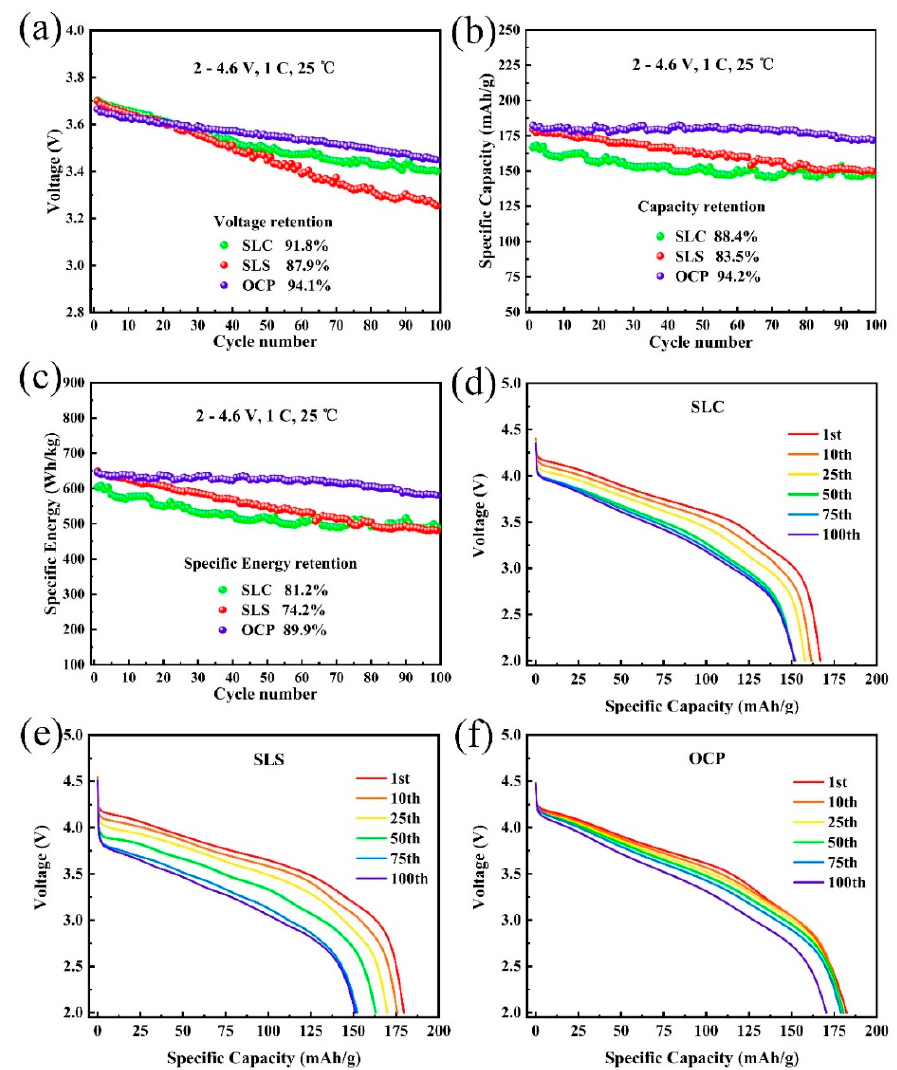
Figure 6. Voltage and capacity decay of LL-811 samples prepared by different methods: ( a ) voltage decay, ( b ) specific capacity decay, ( c ) specific energy decay, ( d – f ) discharge curves for di ff erent cycles. Table 2. Impedance and lithium ion di ff usion coe ffi cient of LL-811 prepared by di ff erent methods.